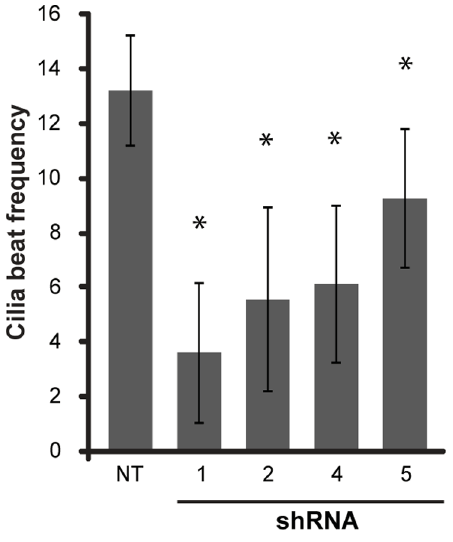
Figure 5. Cilia beat frequency. Mean cilia beat frequency in cells transfected with different shRNA targeted LRRC6 sequences (n=50 fields, ANOVA with Bonferroni correction, p , 0.005). (*) indicates a significant difference compared to control samples.